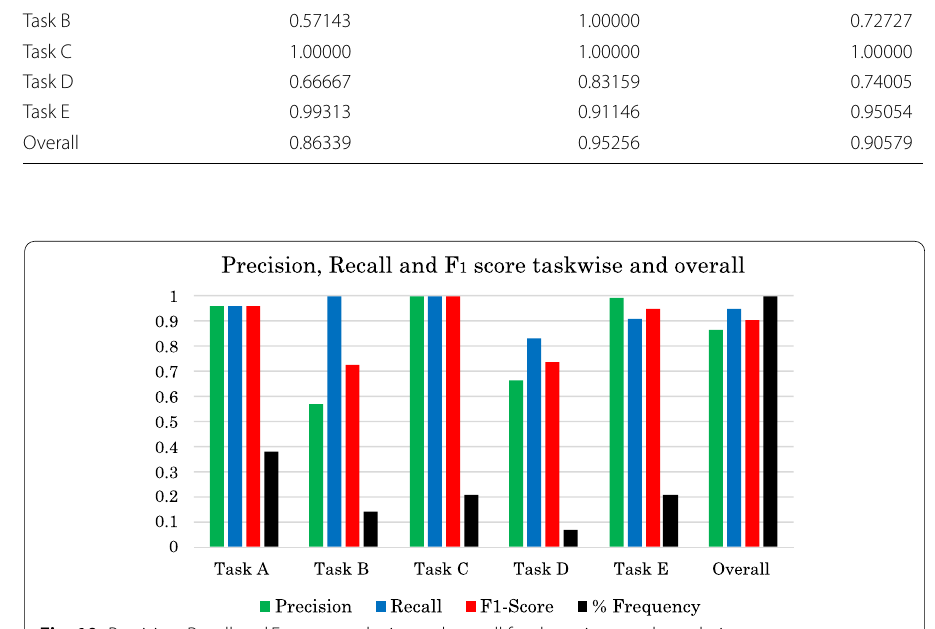
Fig. 10 Precision, Recall and F 1 scores taskwise and overall for detecting word